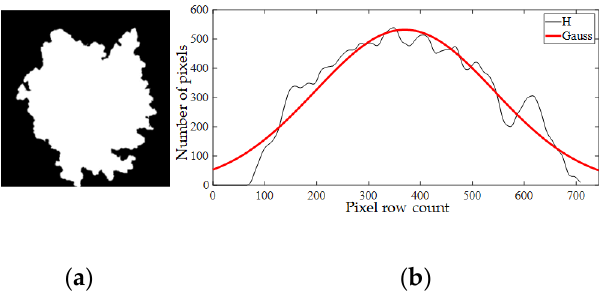
Figure 5. ( a ) An individual tree; ( b ) Projection histogram in the horizontal direction. x-label represents pixel row count of an image from top to bottom. y-label represents number of pixels on each row.